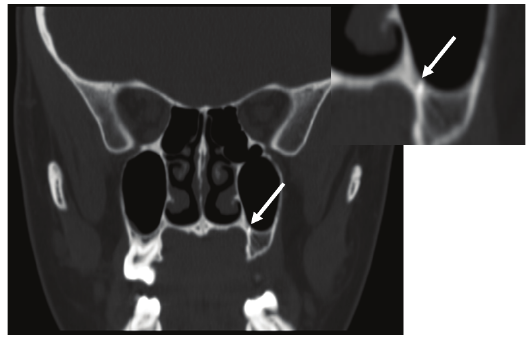
Figure 2. Repeat non-contrasted coronal CT scan. Retained gutta- percha (white arrow) noted in left maxillary sinus. Inset in the top right corner reveals a zoomed image of the